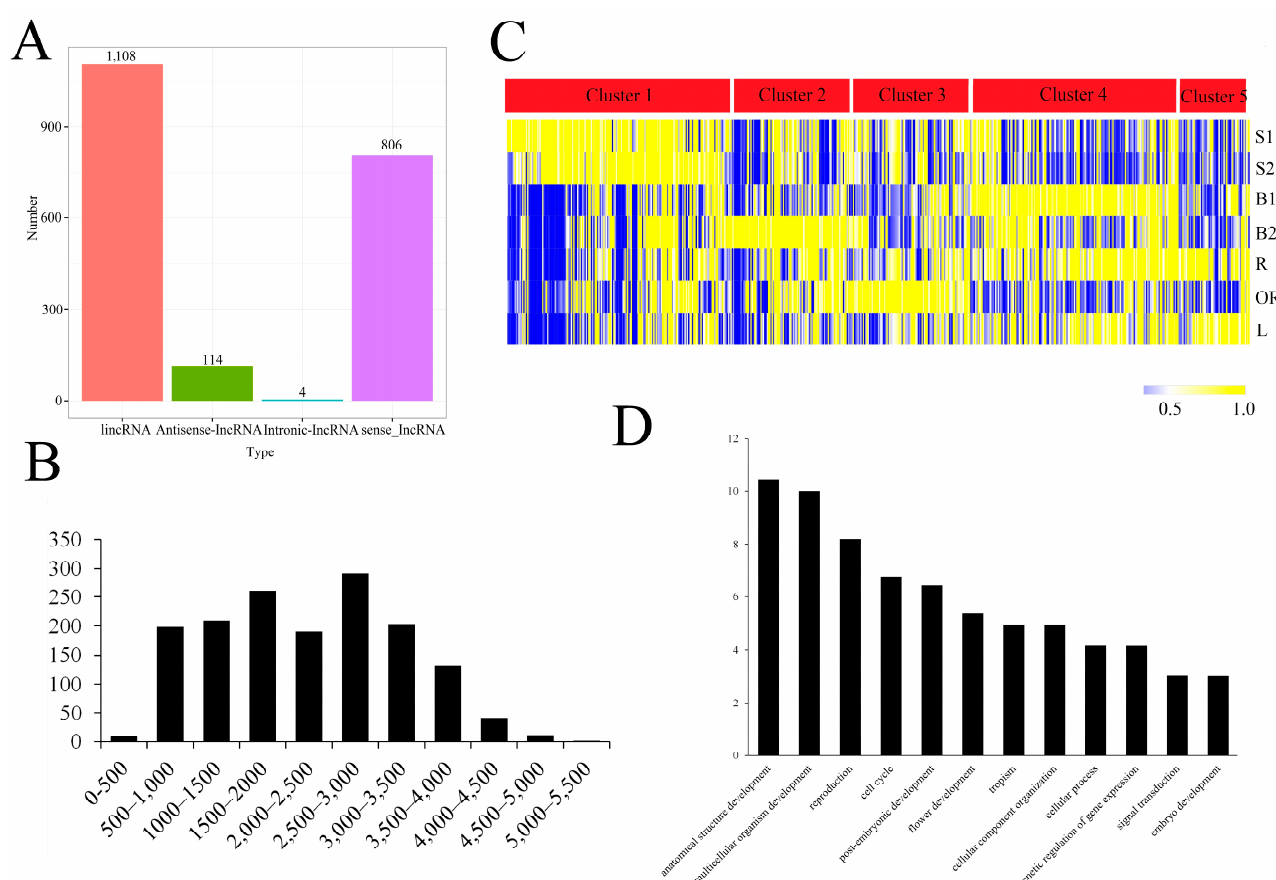
Figure 4. Features of long non ‐ coding RNAs in the Moso bamboo growing culms. ( A ) The quantity of each type of lncRNA. ( B ) The lncRNA length distribution. ( C ) Expression patterns of all 1311 expressed lncRNAs. ( D ) GO annotation of all predicted target genes of lncRNA.